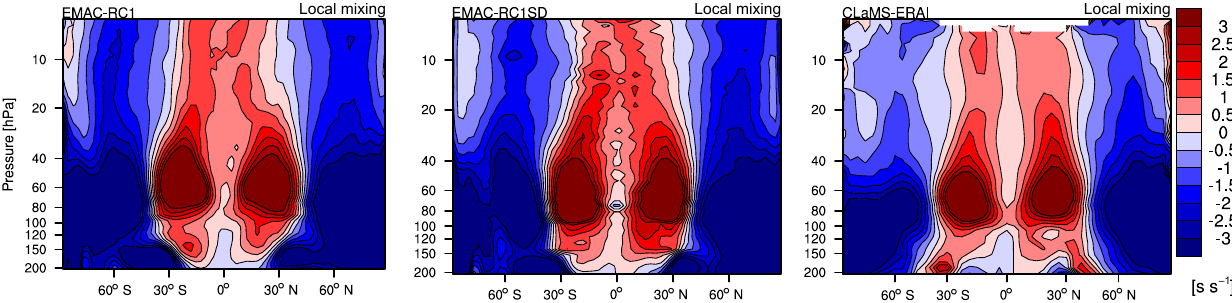
Figure 2. Zonal annual mean of the local mixing tendency (sum of horizontal and vertical contribution) on the AoA tendency budget